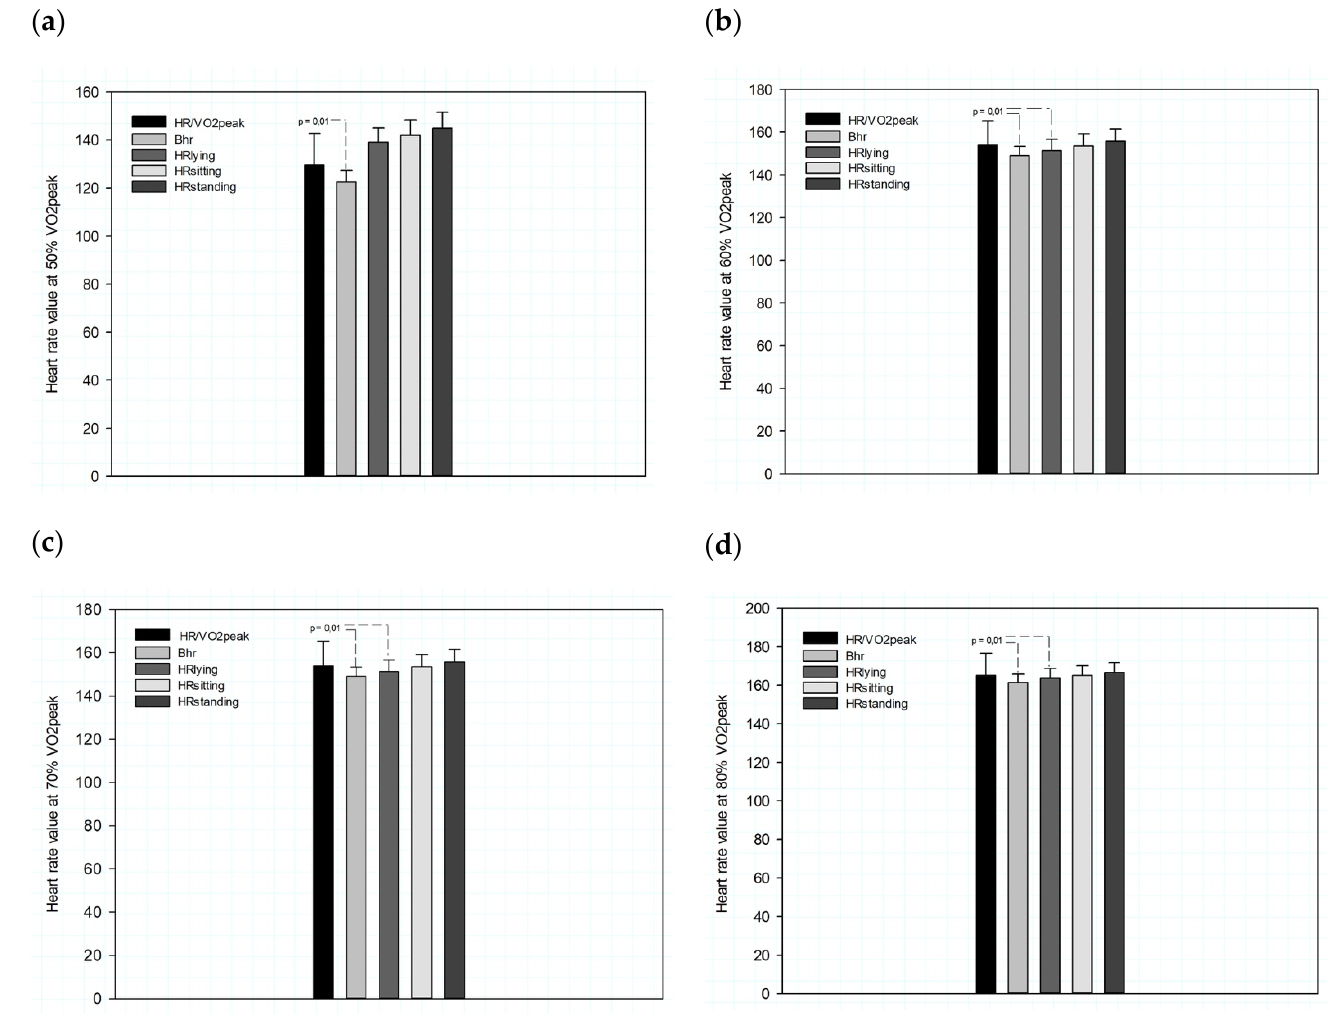
Figure 2. Baseline and resting heart rate measured in different positions for intensities 50, 60, 70 and 80% of the peak oxygen consumption and the respective heart rate (HR/VO 2 peak). Charts ( a – d ) show the values for intensities 50, 60, 70 and 80% of peak oxygen consumption and the respective heart rate (HR/VO 2 peak) and for the intensities calculated by resting heart rate in the positions: baseline (Bhr), lying (HR lying ), sitting (HR sitting ), and standing (HR standing ) for a sample of young individuals of both sexes.